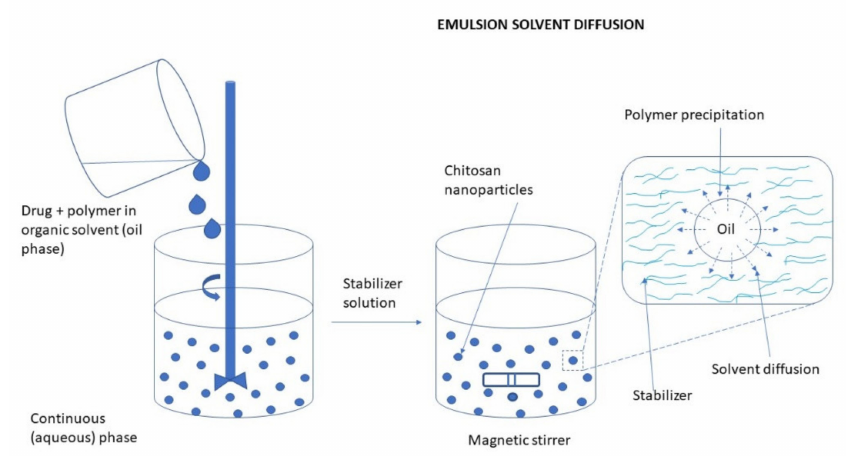
Figure 6. Preparation of CS NPs by emulsion solvent diffusion method.